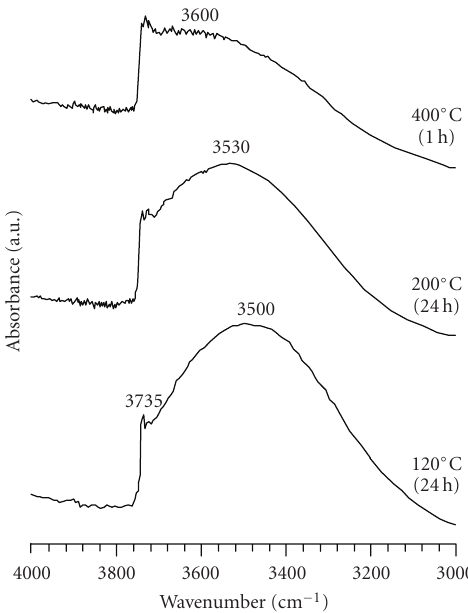
Figure 6: FTIR spectra of the sample 3Nb/TS-1 in the hydroxyls region after evacuation under vacuum at temperature 120, 200, and 400 ◦